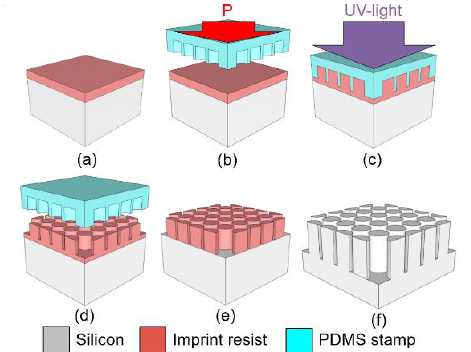
Figure 1. Schematics of top-down fabrication of SiNWs (GeNWs) using NIL: wafer cleaning followed by spin coating of photo-curable resist on a silicon wafer ( a ). Resist templating ( b ). Curing ( c ). Stamp detachment and removal of residual resist layer ( d , e ). Pattern transfer by cryogenic dry etching ( f